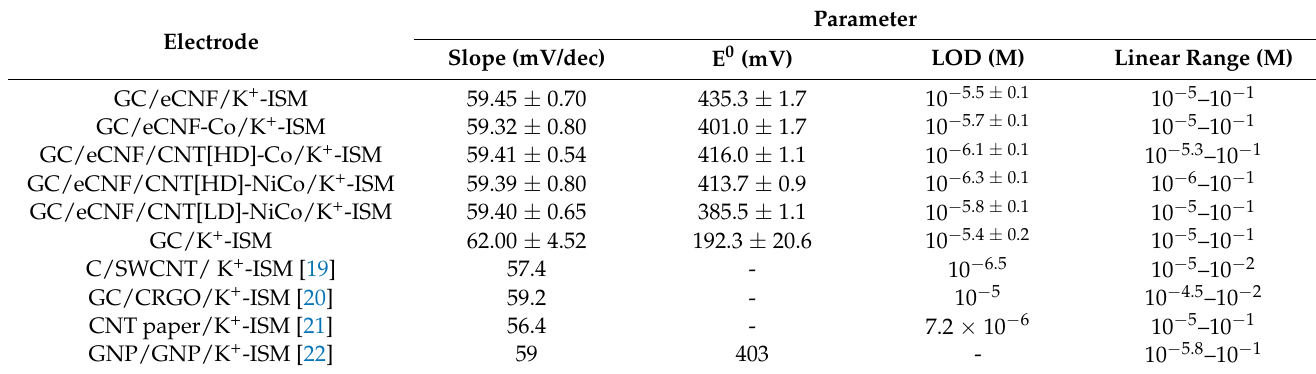
Table 1. Potentiometric parameters of the investigated K +